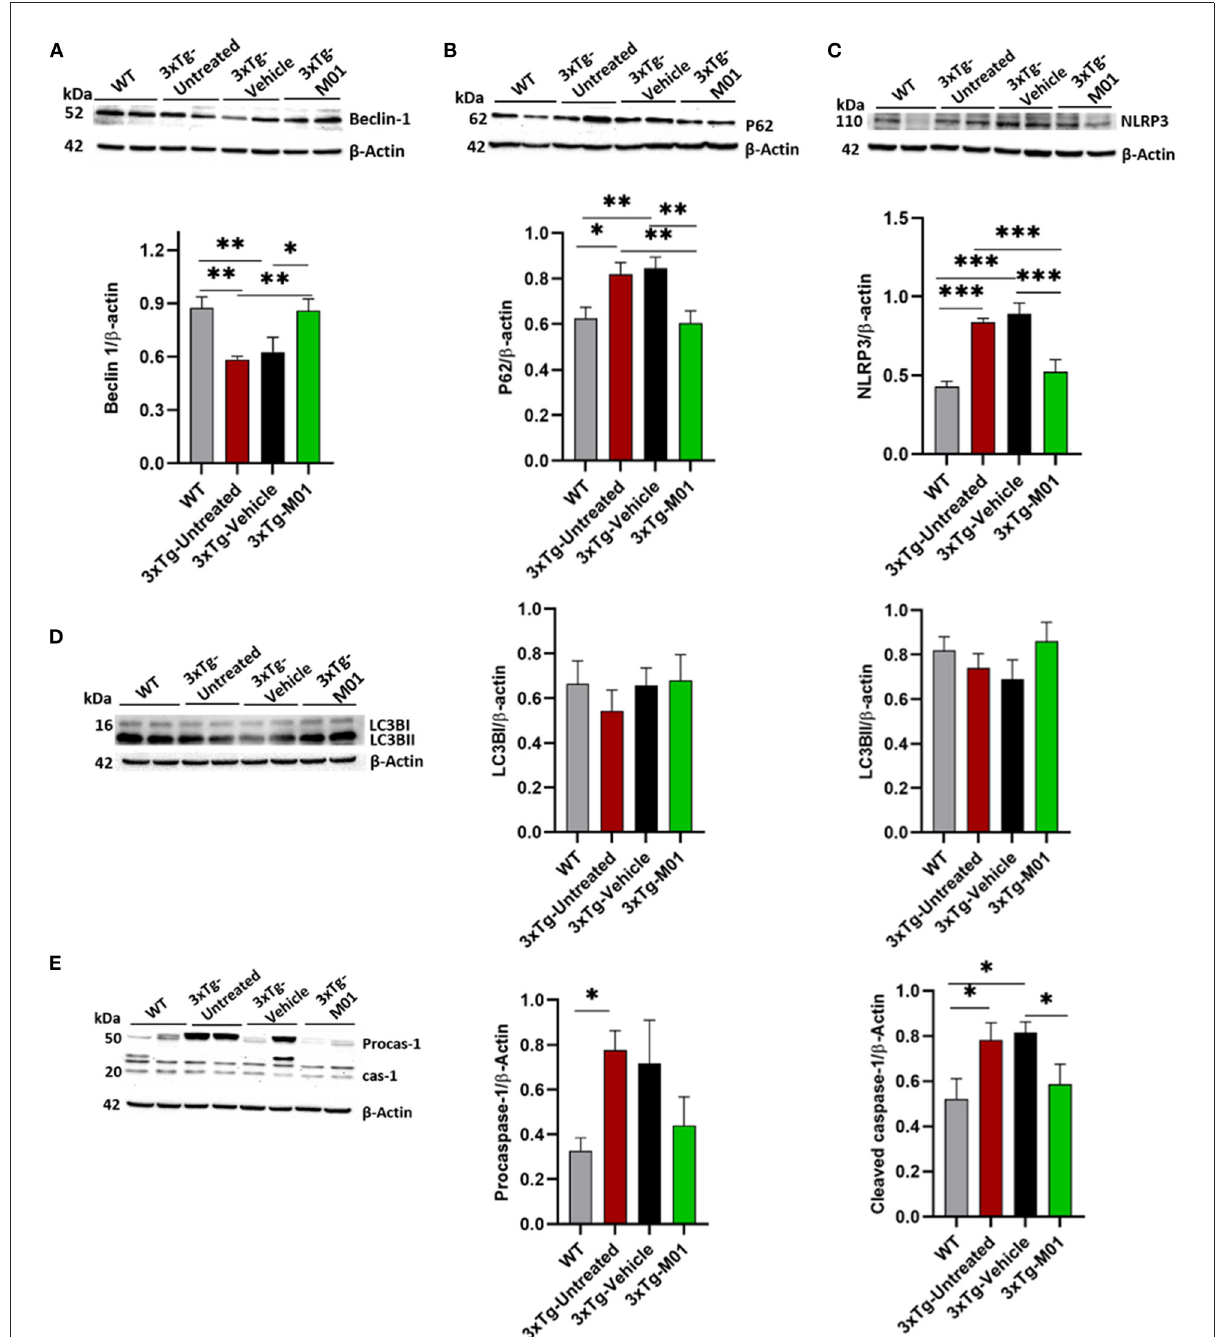
FIGURE3 M01 administration increased the protein expression levels of autophagy-related molecules and decreased NLRP3 in the hippocampus. Immunoblots and quantification graphs of proteins (A) beclin-1expressed significantly less in 3xTg-untreated and vehicle groups compared to WT and M01 groups. (B) P62 expression is high in 3xTg-untreated and vehicle groups, and M01 decreased the P62 to WT level. (C) NLRP3 over-expressed in 3xTg-untreated and vehicle group, M01 administration significantly decreased NLRP3 level. (D) LC3BI & II shows no statistical difference between groups. (E) Pro-caspase-1 expressed significantly higher in 3xTg-untreated group compared to WT group. Cleaved caspase-1 expressed significantly higher in the 3xTg-untreated and -vehicle groups; M01 treatment significantly decreased the caspase-1 level in the hippocampus. The results are plotted as the mean ± SEM. * p ≤ 0.05, ** p < 0.01, *** p < 0.001, n = 6–8/group for western blot